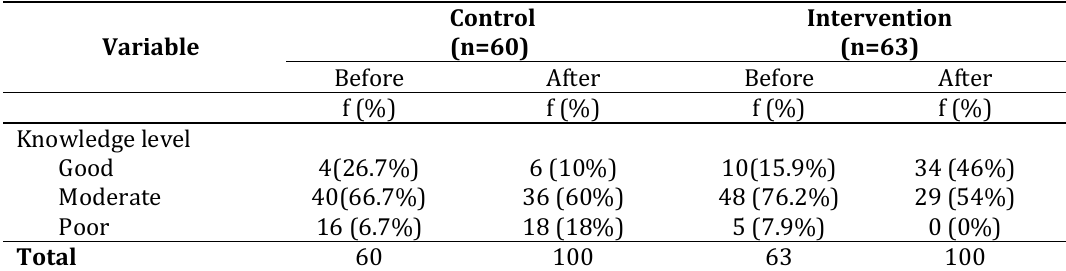
Distribution of Parental Knowledge about Parenting Before and After the Intervention